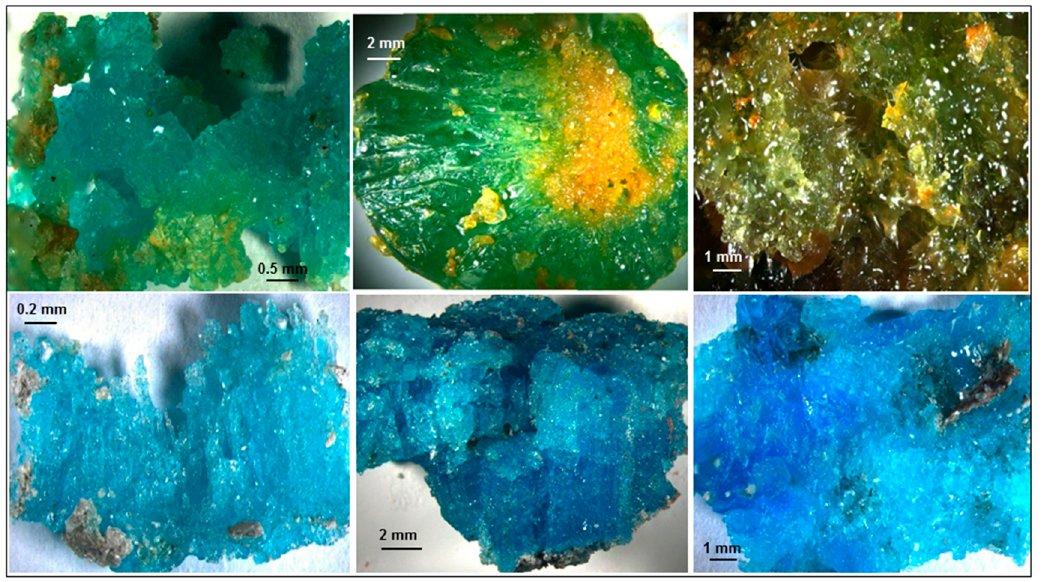
Figure 14. Ternary diagram showing the content of Fe/Cu/Zn in melanterite samples from walls (red) and from stalactites/stalagmites (black). As an historical reference, a pigment, known as “Azul de Aljustrel” (Aljustrel Blue), was described in a document from King John III (16th century) and referred to as being produced in Aljustrel by a regal functionary, refined and sold to artists [34]. The use of “Azul de Aljustrel” pigment is thought to have been an episode lasting only a few years, as no other references are known [35]. Concerning its nature, it is supposed that it might have been a pigment based on copper sulphates or basic copper carbonates existing in the sulphur deposits of the Aljustrel region [36]. In similar deposits in the Spanish IPB, ancient references about the collection of materials in pits for making paint and for medicinal use (probably in Rio Tinto) led Rebollar [37] to consider that these materials were sulphates and melanterite rather than chalcanthite. In the case of the Algares adit, melanterite stalactites and stalagmites are located below the old ore silo opening on the roof of the adit. In fact, above the gallery, crushed massive sulphide ore is still present, and through the air flow and rainwater percolation, the precipitation of sulphates occurs in the mine adit roof and floor.